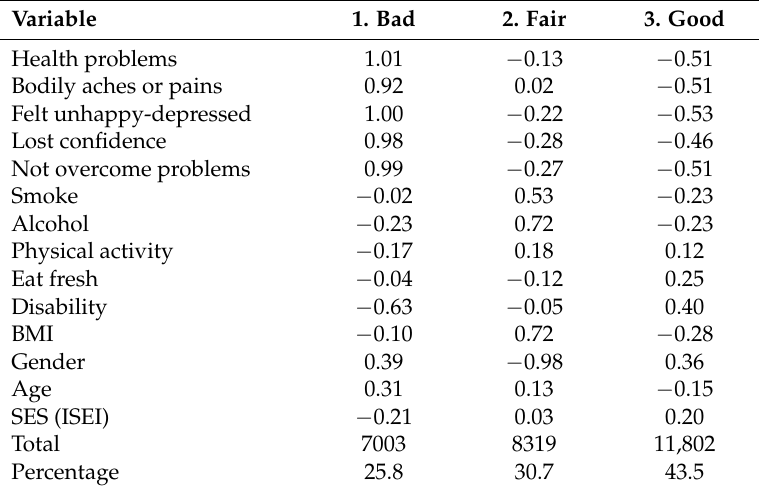
Table 2. Final cluster results.